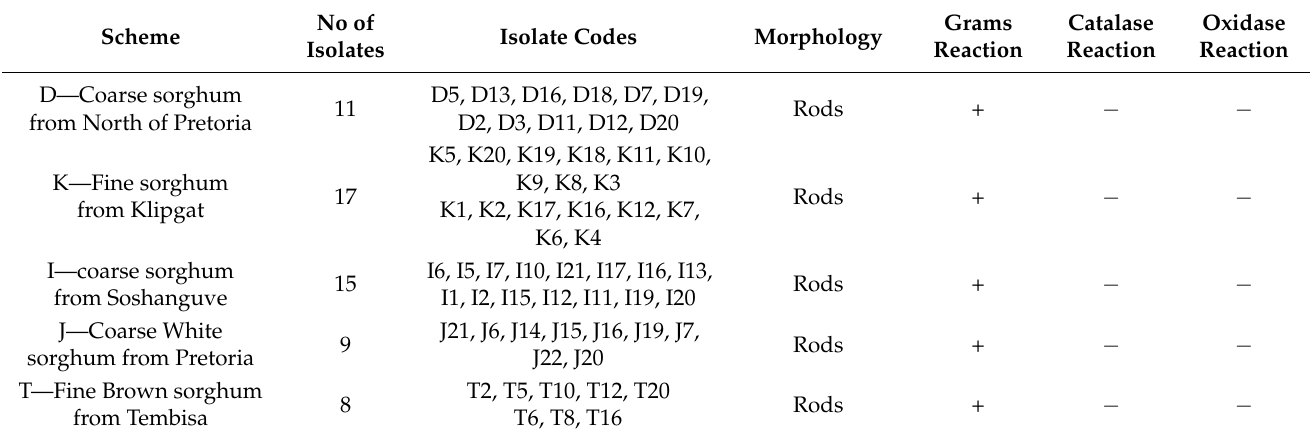
Phenotypic characterization of sorghum isolates from spontaneously fermented sorghum